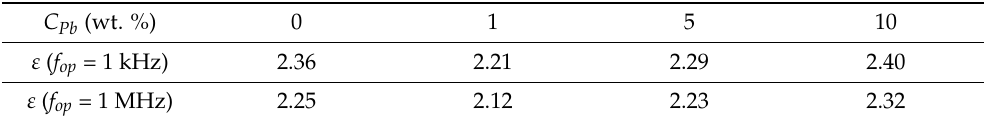
Table 4. Results of measurements of ε Pb-containing composites at frequencies of 1 kHz and 1